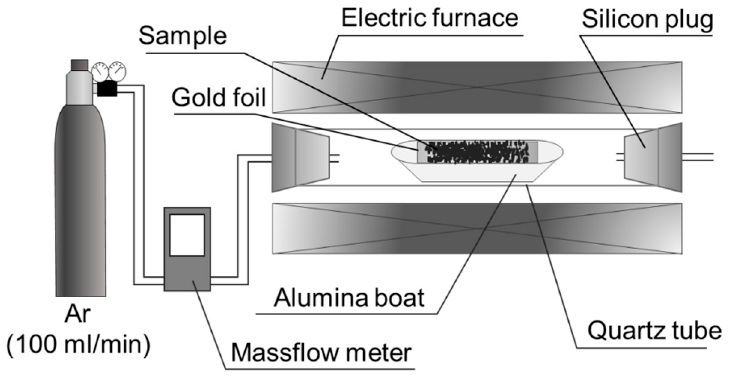
Figure 1. Overview of calcination test equipment.